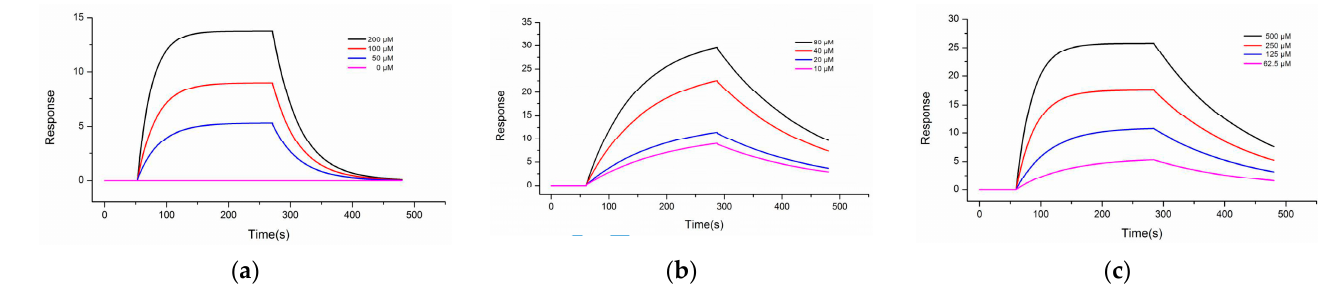
Figure 2. Concentration-gradient binding curves of recombinant human Cdc20 protein to ( a ) Apcin; ( b ) compound 20 ; ( c ) compound 27 . Molecules were tested in a dilution series starting at 500 µ M. The analyte was diluted with buffer and loaded at 20 µ L/min. The binding time of the analyte and the ligand was 240 s, and the natural dissociation time was 480 s. The analysis software used for the experimental results was TraceDrawer (Ridgeview Instruments AB, Sweden), and the analysis method was the one-to-one analysis